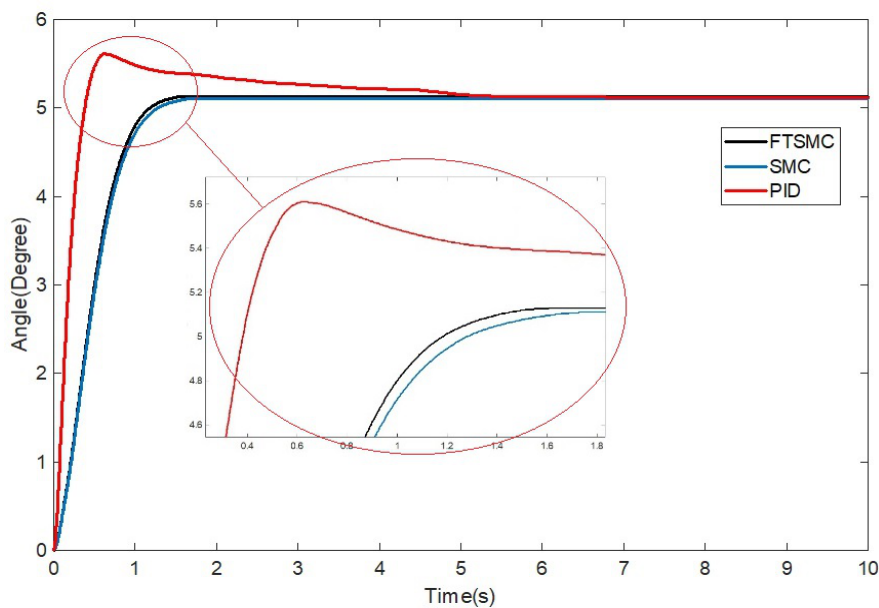
Figure 10. Experiment results under mass load